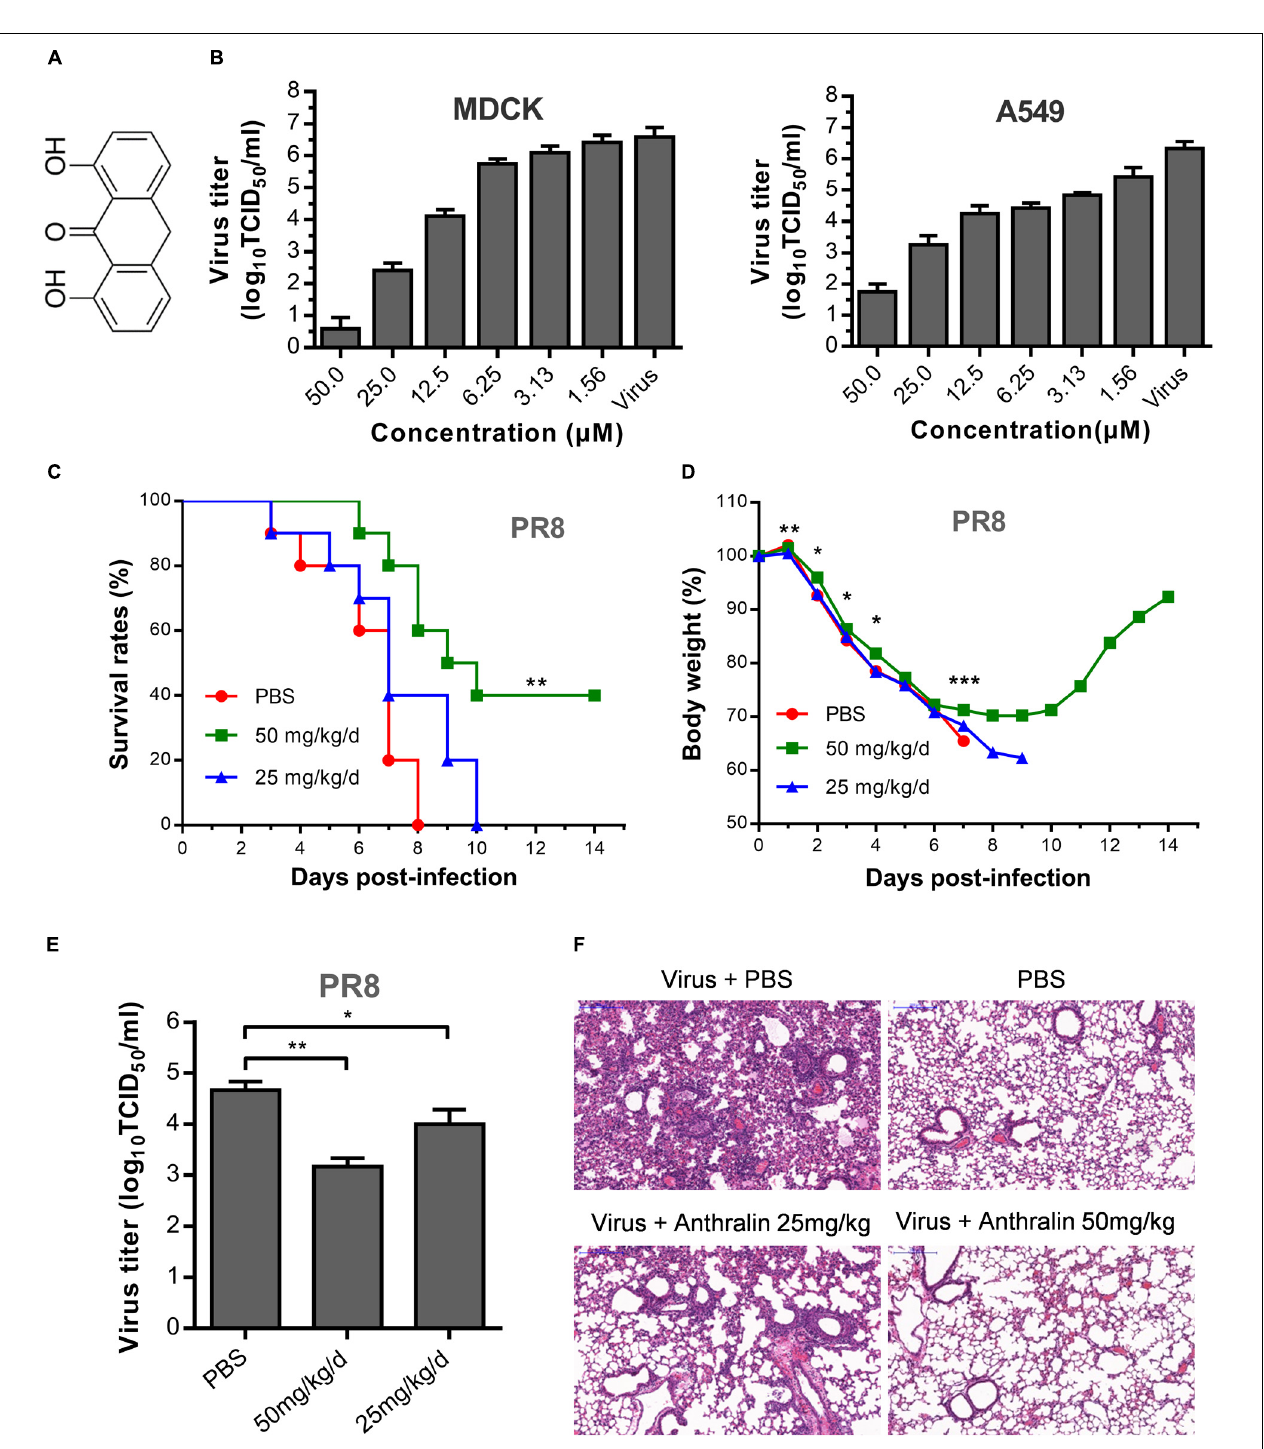
FIGURE 1 | The antiviral activity of anthralin in vitro and in vivo . (A) Chemical structures of anthralin. (B) The antiviral effects of anthralin on the production of infectious virions on two cell lines. The supernatants were harvested and the virus titers were determined by TCID 50 assay. Virus titers were calculated according to Spearman–Karber method as described in methods. The values represent the means ± S.D. of duplicate samples from three independent experiments. (C) Effect of anthralin administration on survival rates in the infected mice. BALB/c mice were infected with 1000 TCID 50 of PR8 and treated with anthralin or PBS control ( n = 10). ** P < 0.01 with respect to PBS controls. (D) Weight loss of mice infected with lethal influenza virus and treated with or without anthralin. * P < 0.05, ** P < 0.01 and *** P < 0.001 with respect to PBS controls. (E) Virus titers in BALFs taken on the third day after infection were measured by TCID 50 assay determined on MDCK cells. (F) Haematoxylin & Eosin-stained sections from lungs of non-infected and PR8-infected BALB/c mice treated with anthralin or PBS at 3 dpi (day post infection) (scale = 200 µ m).